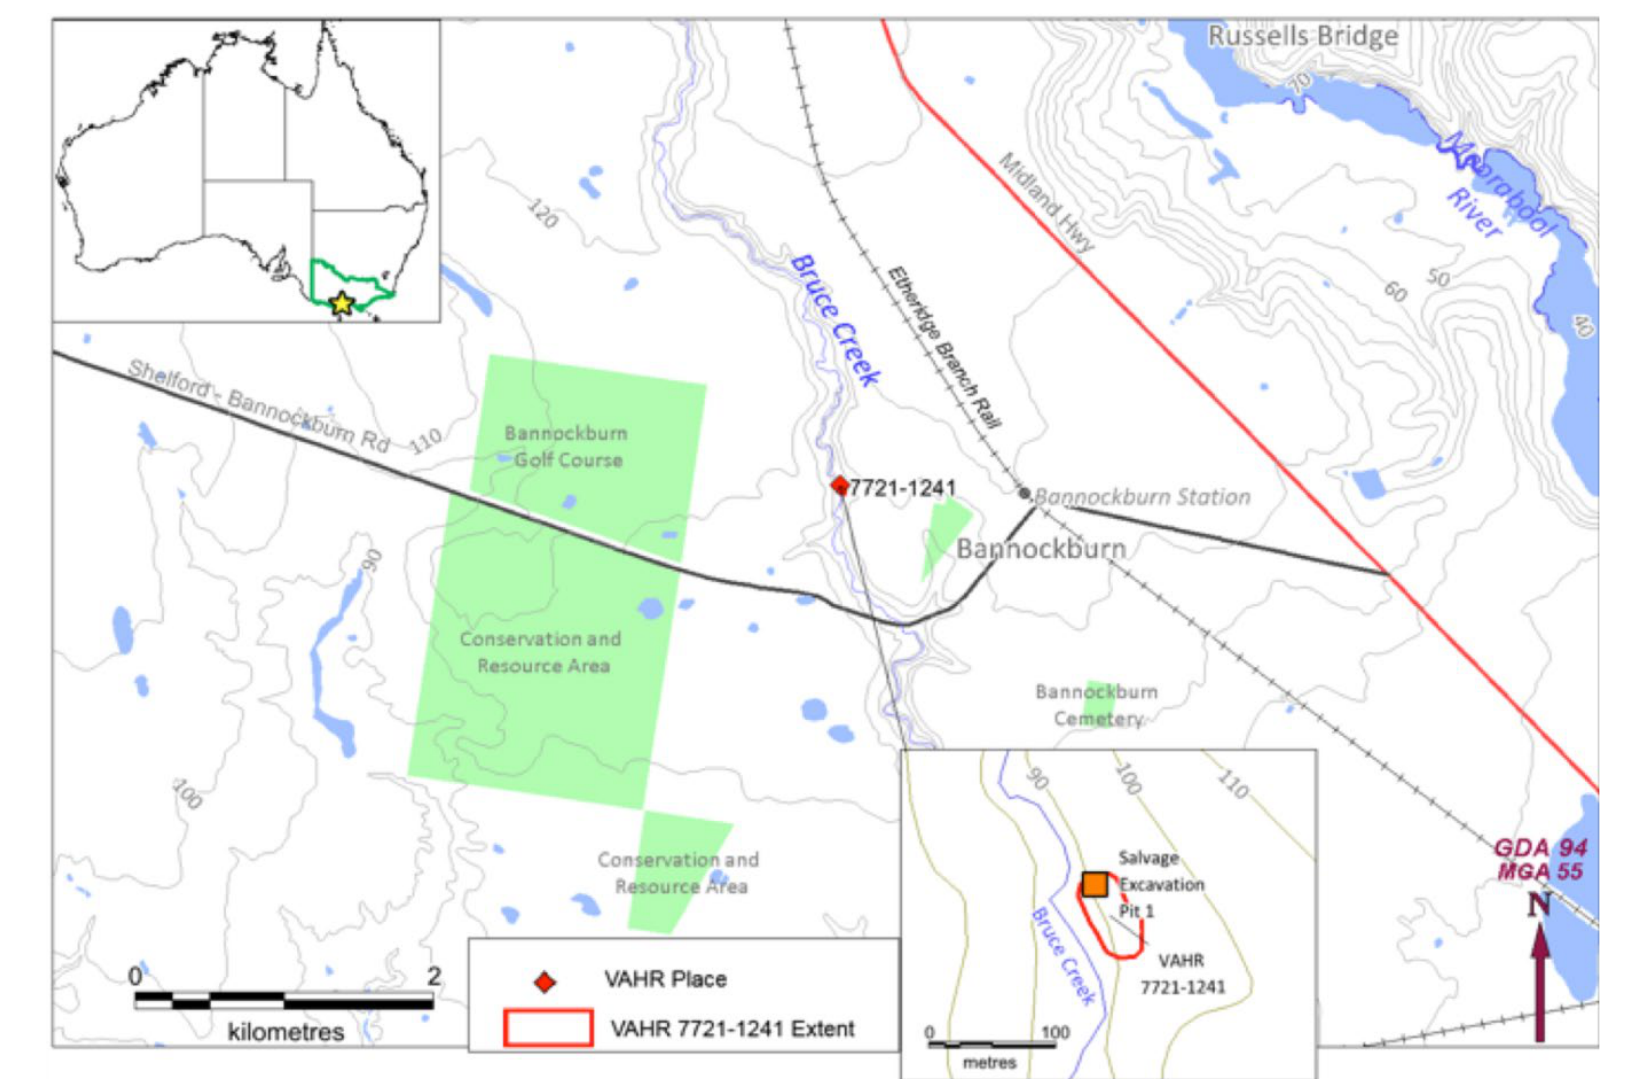
Figure 1. Site location showing Salvage Excavation Pit 1 (SEP1), site VAHR 7721-1241 and